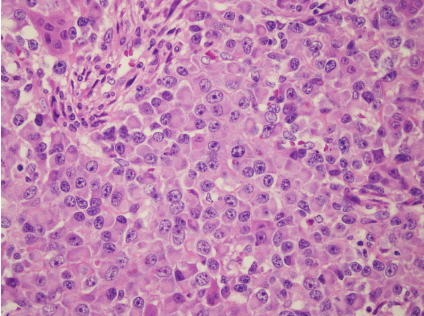
revealed a well-circumscribed tumour (4,2 × 3 cm) brown in color and hard in consistency, with areas of calcification.